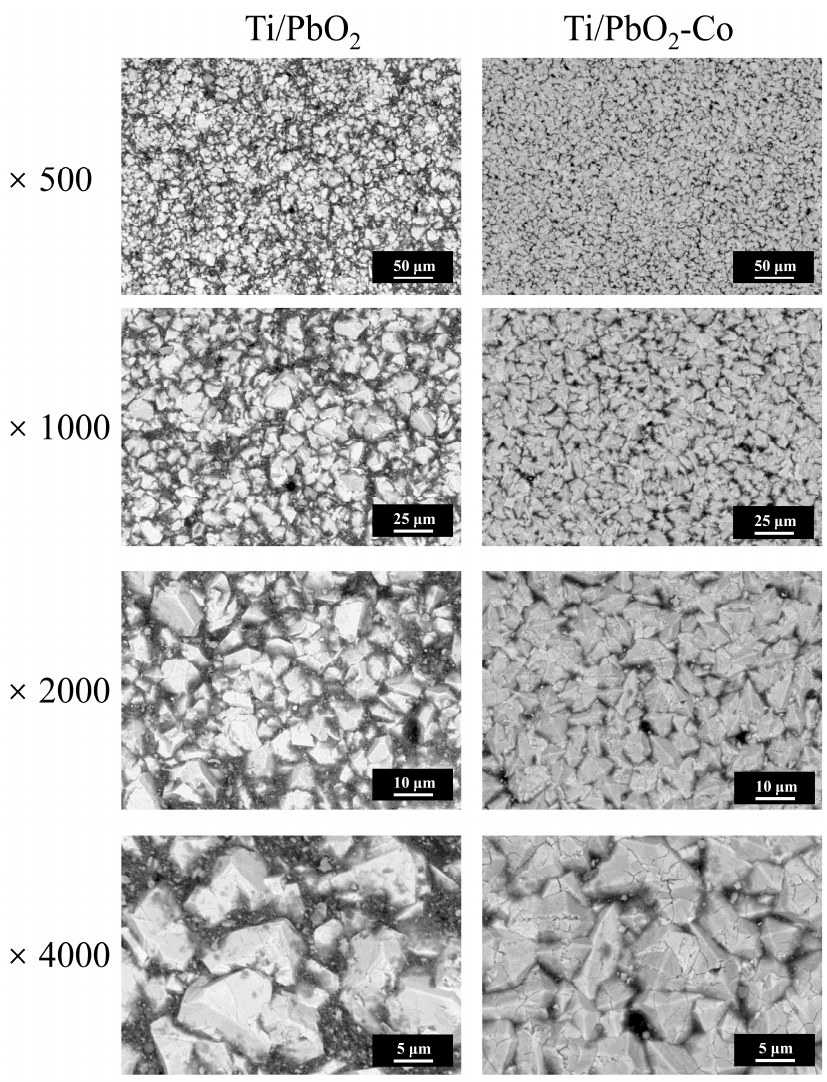
Figure 2. SEM images of the Ti/PbO 2 surface.